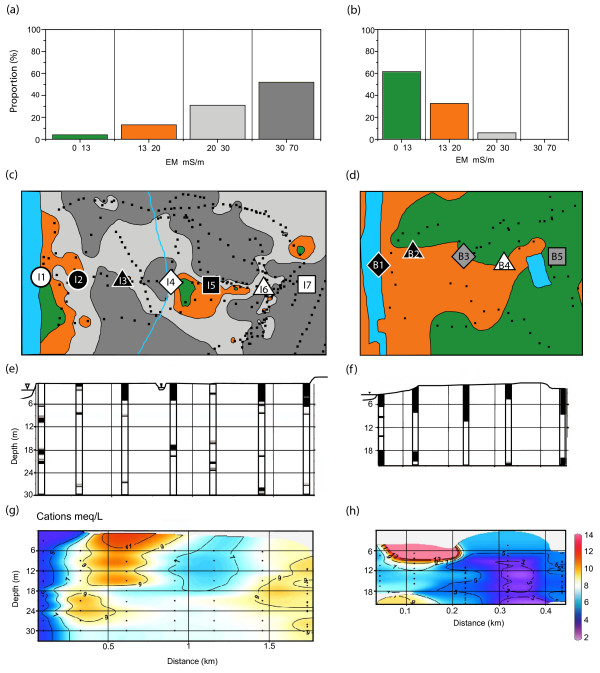
Histogram of EM conductivities around (a) Chakdaha, India and (b) Balia Para, Bangladesh. The location of the measurements is shown by black symbols on a contour map of EM conductivity, color-coded in the same ranges as in the histogram (c-d). Also shown are the locations of needle-sampler profiles using the same symbols of Fig. 2. (e-f) Lithological cross-sections for the two sites showing the distribution of clay/silt (black) and sand (white). (g-h) Contoured section of major cation concentrations for groundwater collected with the needle-sampler. Sections drawn with Ocean Data View [47].